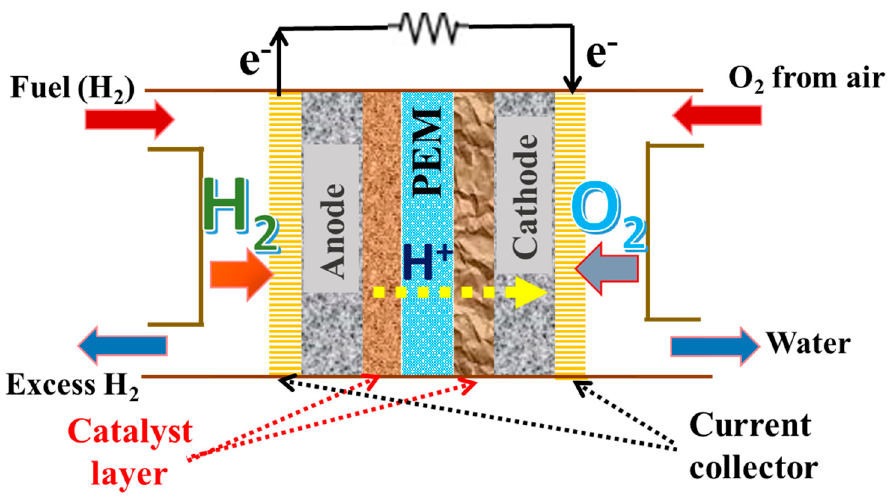
Figure 1. Schematic of Hydrogen Fuel Cell.